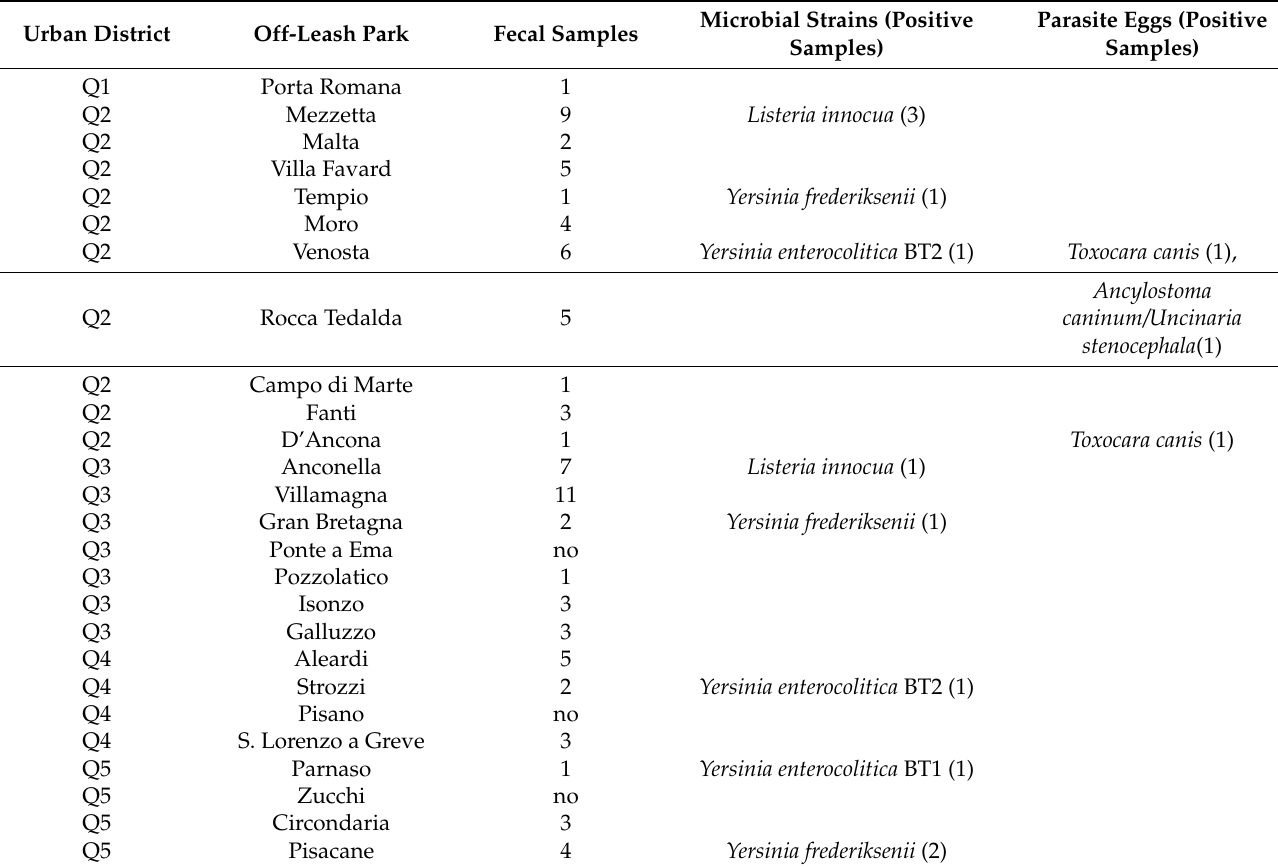
Table 2. The results of microbiological and parasitological analysis on fecal samples collected in the examined areas. Urban District